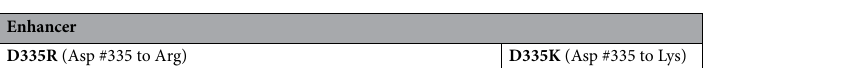
Table 4. Aspartic Acid (Asp/D) amino acid mutants.